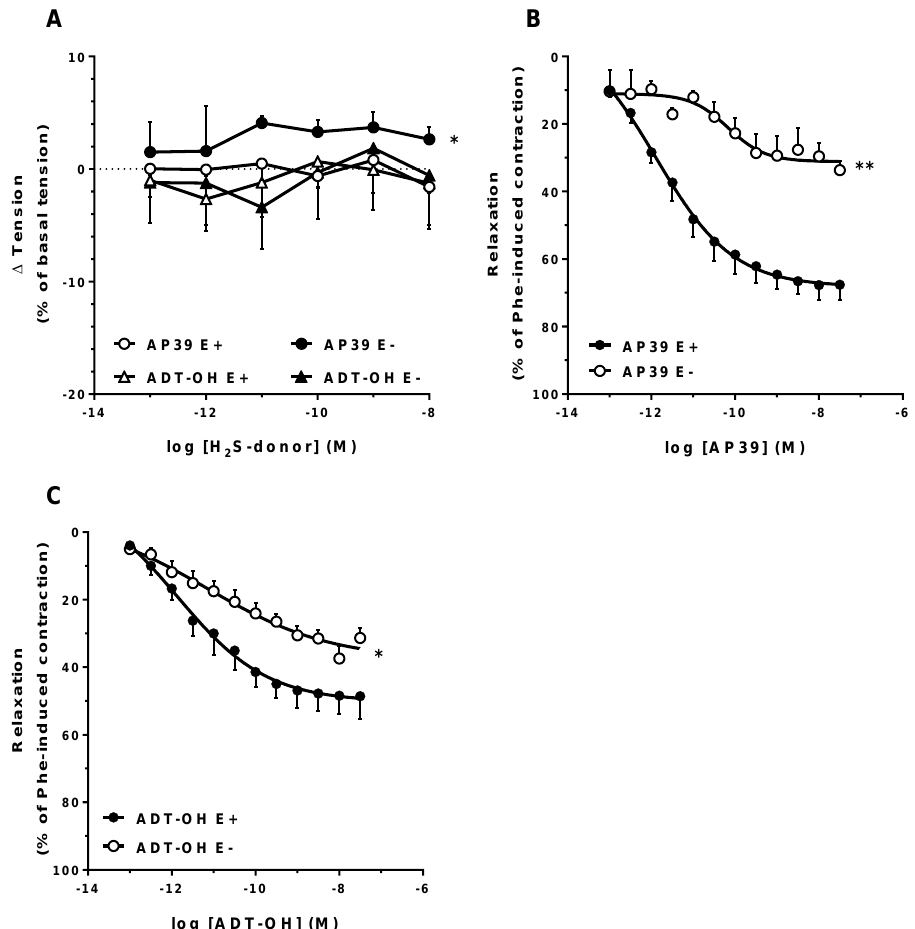
Figure 2. In vitro effects of the H 2 S donors AP39 and ADT-OH on mouse mesenteric artery rings. Panel ( A ) shows the effects of AP39 or ADT-OH on resting tension, as analyzed in both intact and mechanically endothelium-denuded rings. Panels ( B , C ) show the vasorelaxant effects of AP39 and ADT-OH, respectively, on Phe precontracted rings, either intact (E+) or after the mechanical removal of the endothelial layer (E − ). * p < 0.05 and ** p < 0.01 vs. E+ E max (as analyzed by the Student’s t -test for unpaired data; n = 5 – 7/group).